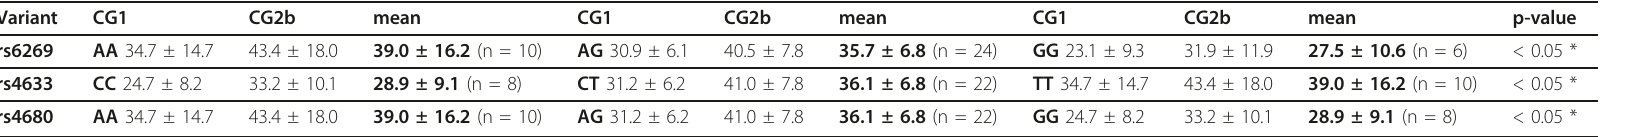
Table 2 S-COMT methylation [% ± SD] with respect to COMT genotypes in Saliva DNA (twin cohort)